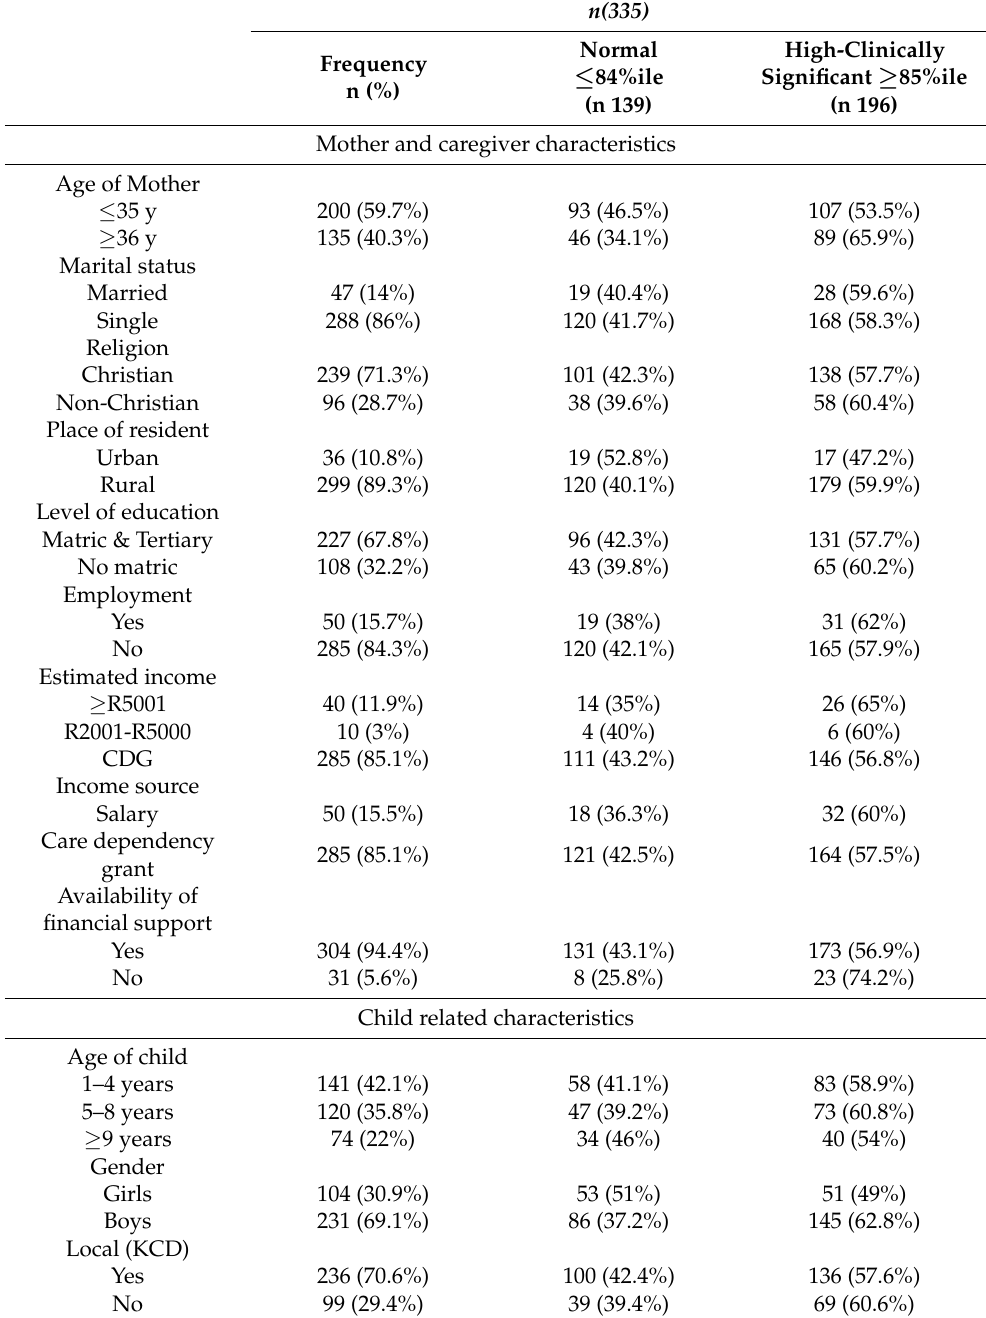
Table 3. Parental stress levels and socio-demographic